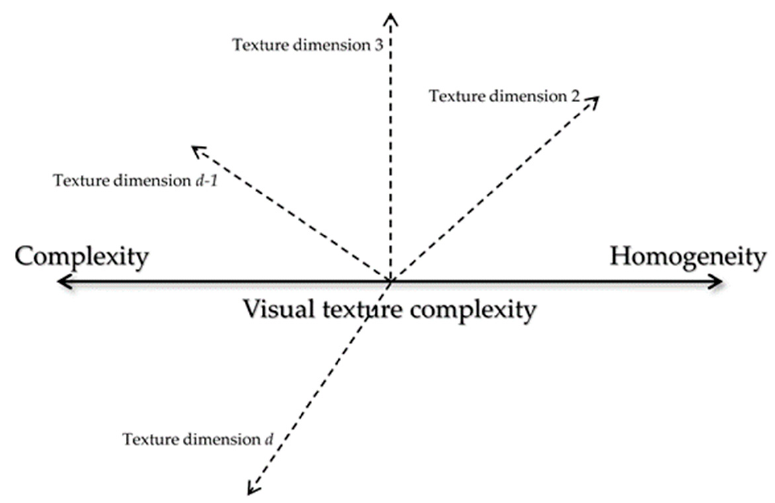
Figure 8. The hypothetical perceptual texture space with visual texture complexity as one of its di- mensions.